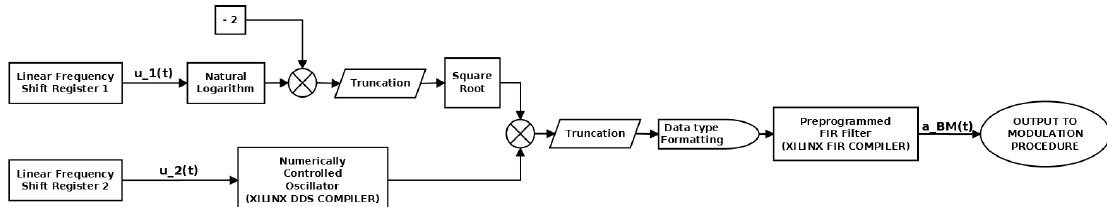
Figure 10. Block diagram of the pseudorandom waveform generation method considering the Box–Muller transform approach in Xilinx ® System